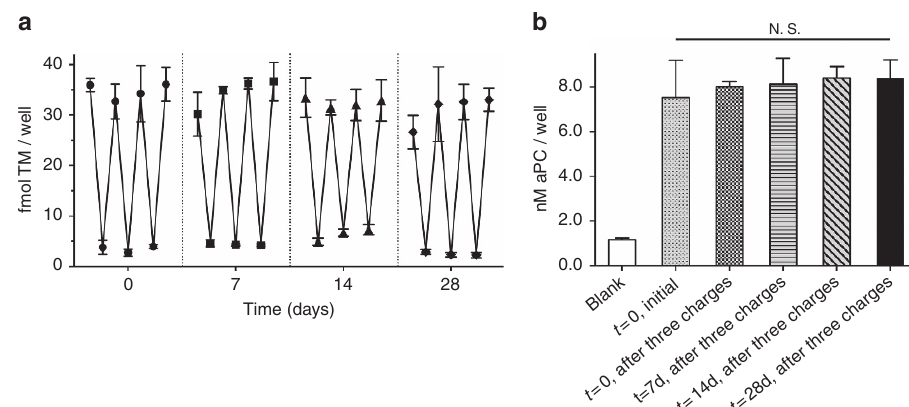
Figure 2 | Repetitive surface assembly and removal over 28 days in vitro . ( a ) Sequential eSrtA-catalysed charging and stripping of TM LPETG performed at 7-day intervals over a 28-day incubation. ( b ) aPC activity was confirmed on initial surfaces and after three strip/charge events performed on days 7, 14 and 28. N.S. (not significant), error bars denote s.d. ( n Z 3).